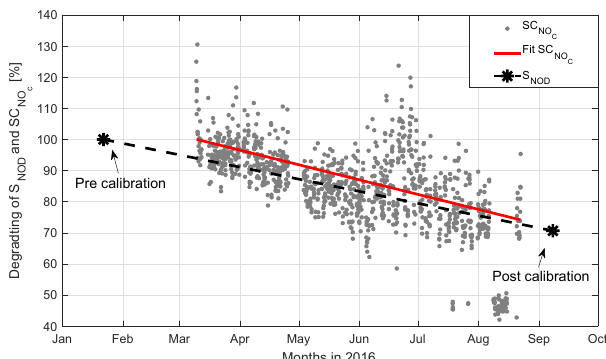
Figure 8. Linear degrading of the NO detector sensitivity ( S NOD , black) after pre- and post-calibration in percent. The in-flight sta- bility check of NO 2 (gray dots) confirms the linear behavior of the degradation of the detector sensitivity during the deployment, shown as linear robust fit (red